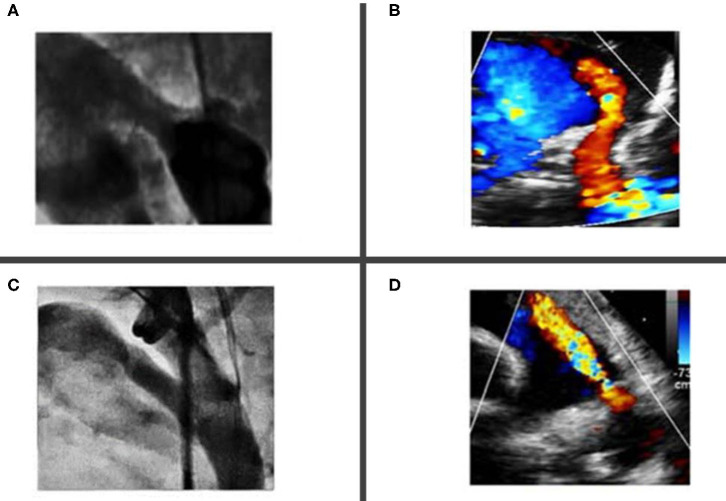
Most common ductal morphology in premature babies undergoing percutaneous closure. (A,B) Showing type “C” tubular ductus without any constrictions at the aortic end or the pulmonary artery end. (C,D) Showing a “fetal type” ductus, which is typical long, wide and tortuous.